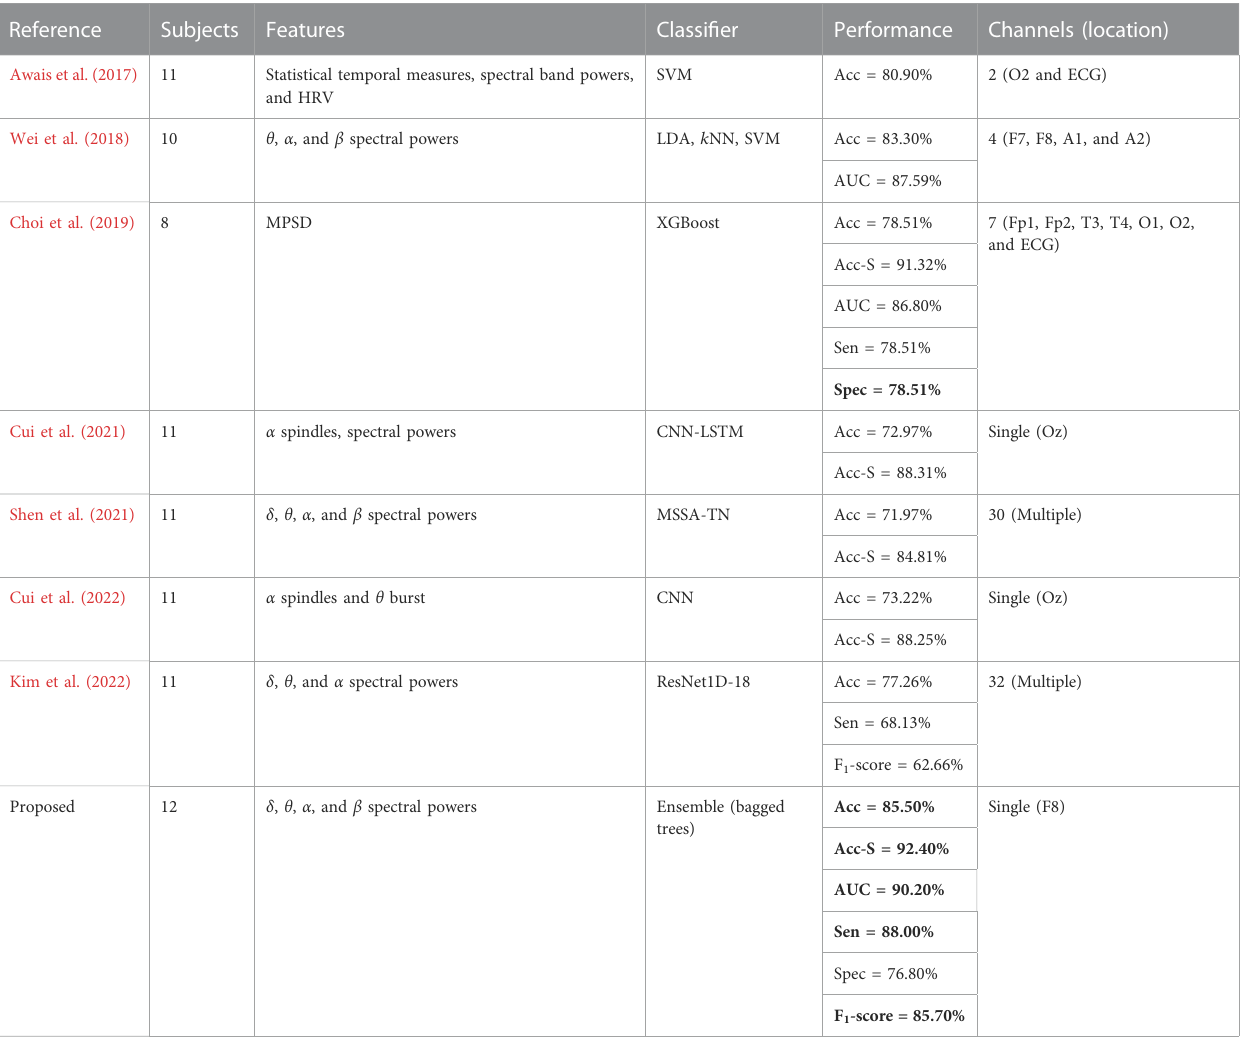
TABLE 3 Detailed comparison of proposed drowsiness detection scheme with existing